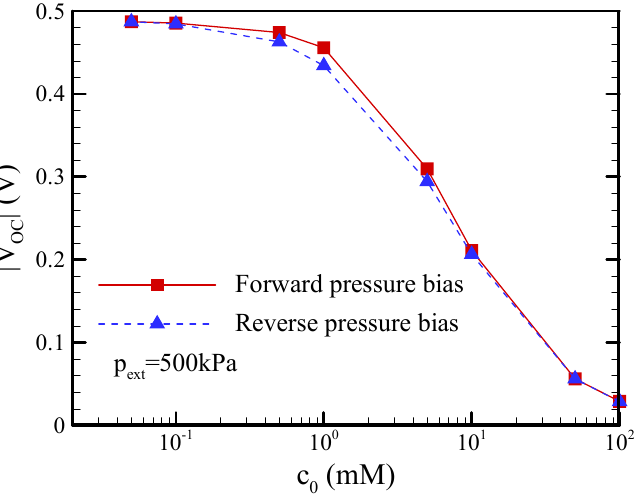
Figure 4. The dependence of the salt concentration on the streaming potential rectification in a conical nanopore. Note that θ = 1.2°, σ s = −5 mC/m 2 , and b = 20 nm.